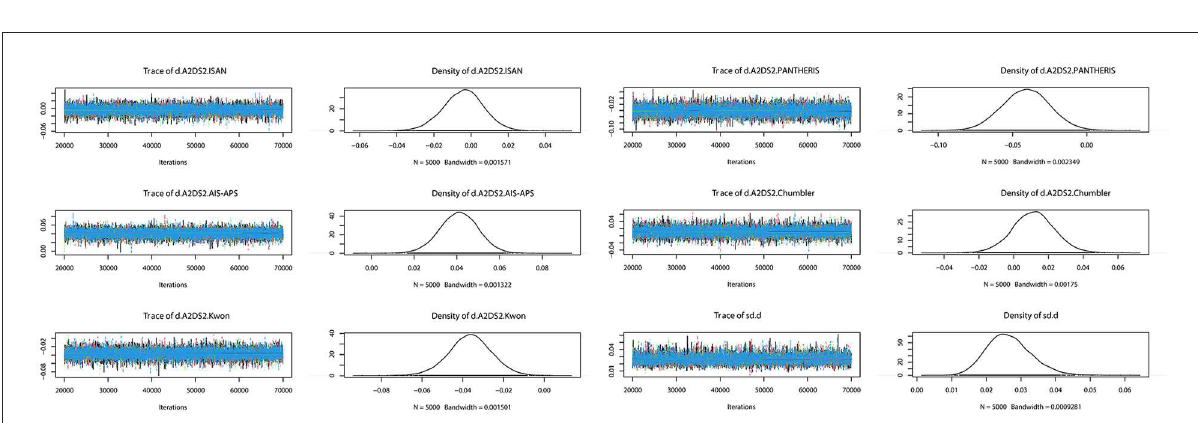
FIGURE5 Trajectory and density graph. Each MCMC chain in the trajectory diagram has reached stable fusion from the beginning part, and the overlapping area accounts for most of the chain fluctuation range in the subsequent calculation, and the fluctuation of a single chain cannot be recognized by the naked eye, so the model convergence degree is satisfactory. The distribution of the graphs in the density map is normal, and the Bandwidth value tends to 0 and reaches stability, and the model convergence degree is satisfactory when combined with the results of the trajectory